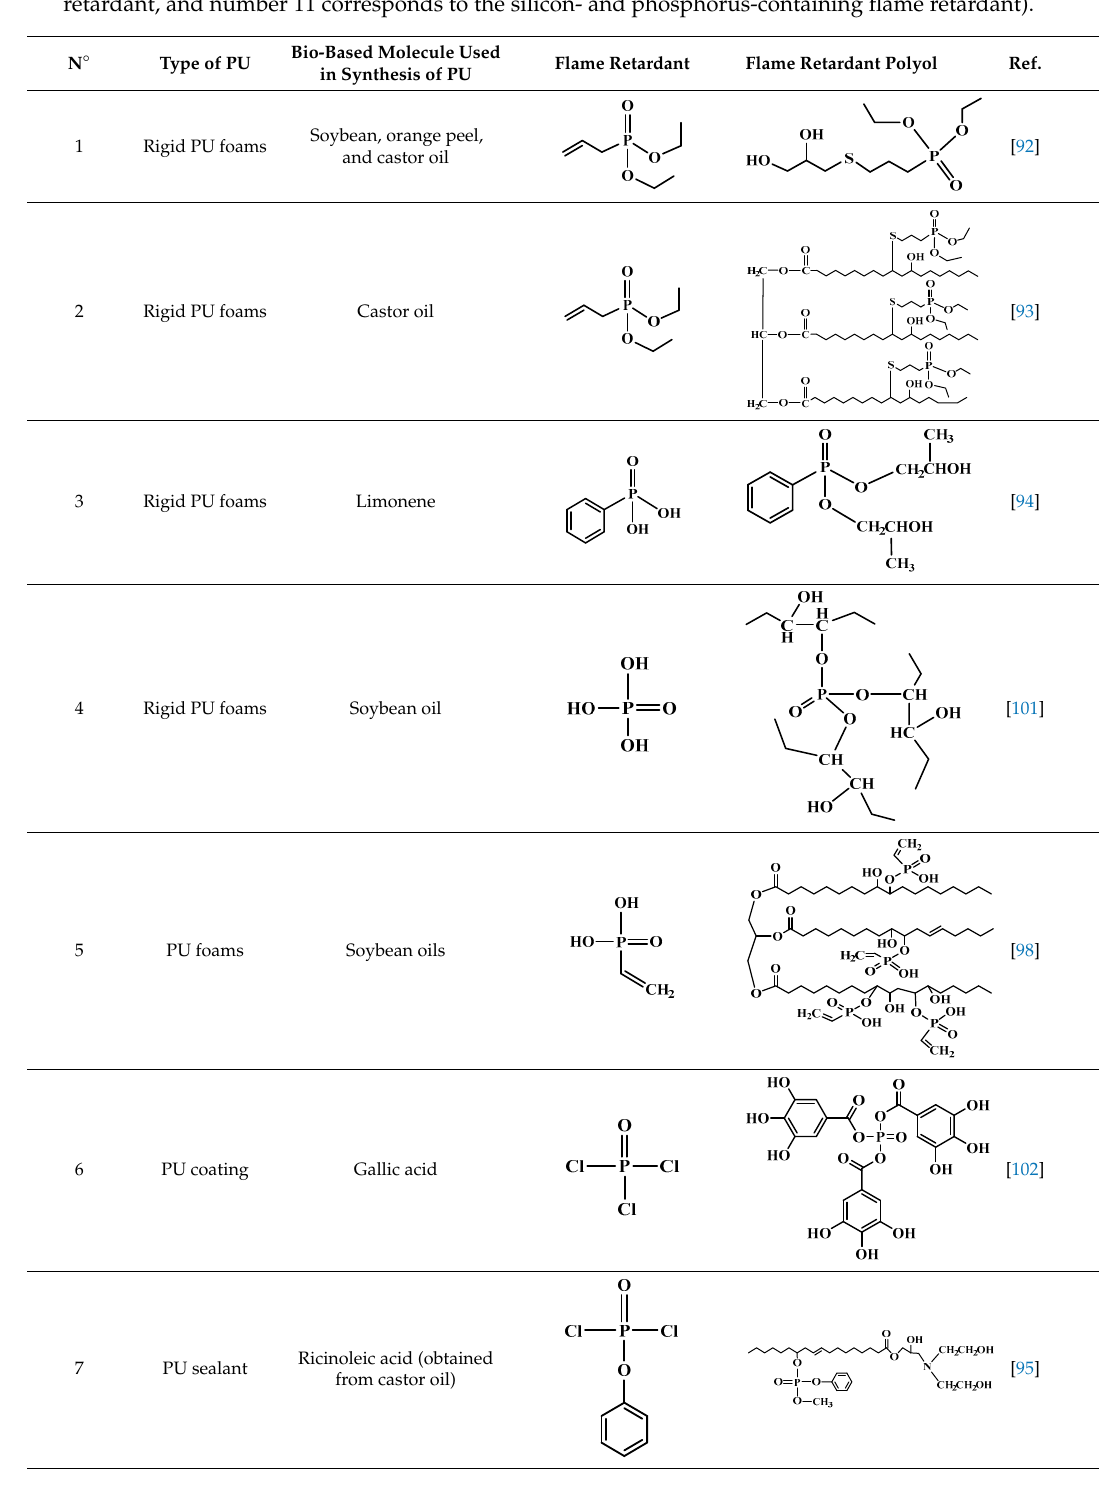
Table 3. Summary of reported works on bio-based PUs using “reactive” flame retardants (numbers 1 to 6 correspond to the phosphorus-containing flame retardant, numbers 7 to 9 correspond to the phosphorus and nitrogen-containing flame retardant, number 10 corresponds to the silicon-containing flame retardant, and number 11 corresponds to the silicon- and phosphorus-containing flame retardant).